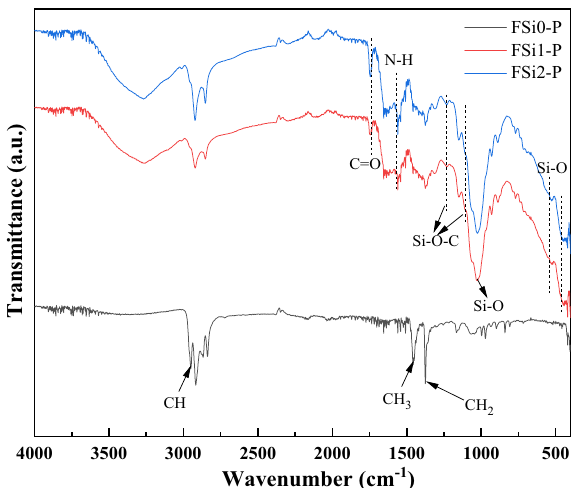
Figure 6. Fourier transform infrared spectroscopy (FTIR) results of the FSi-P group.